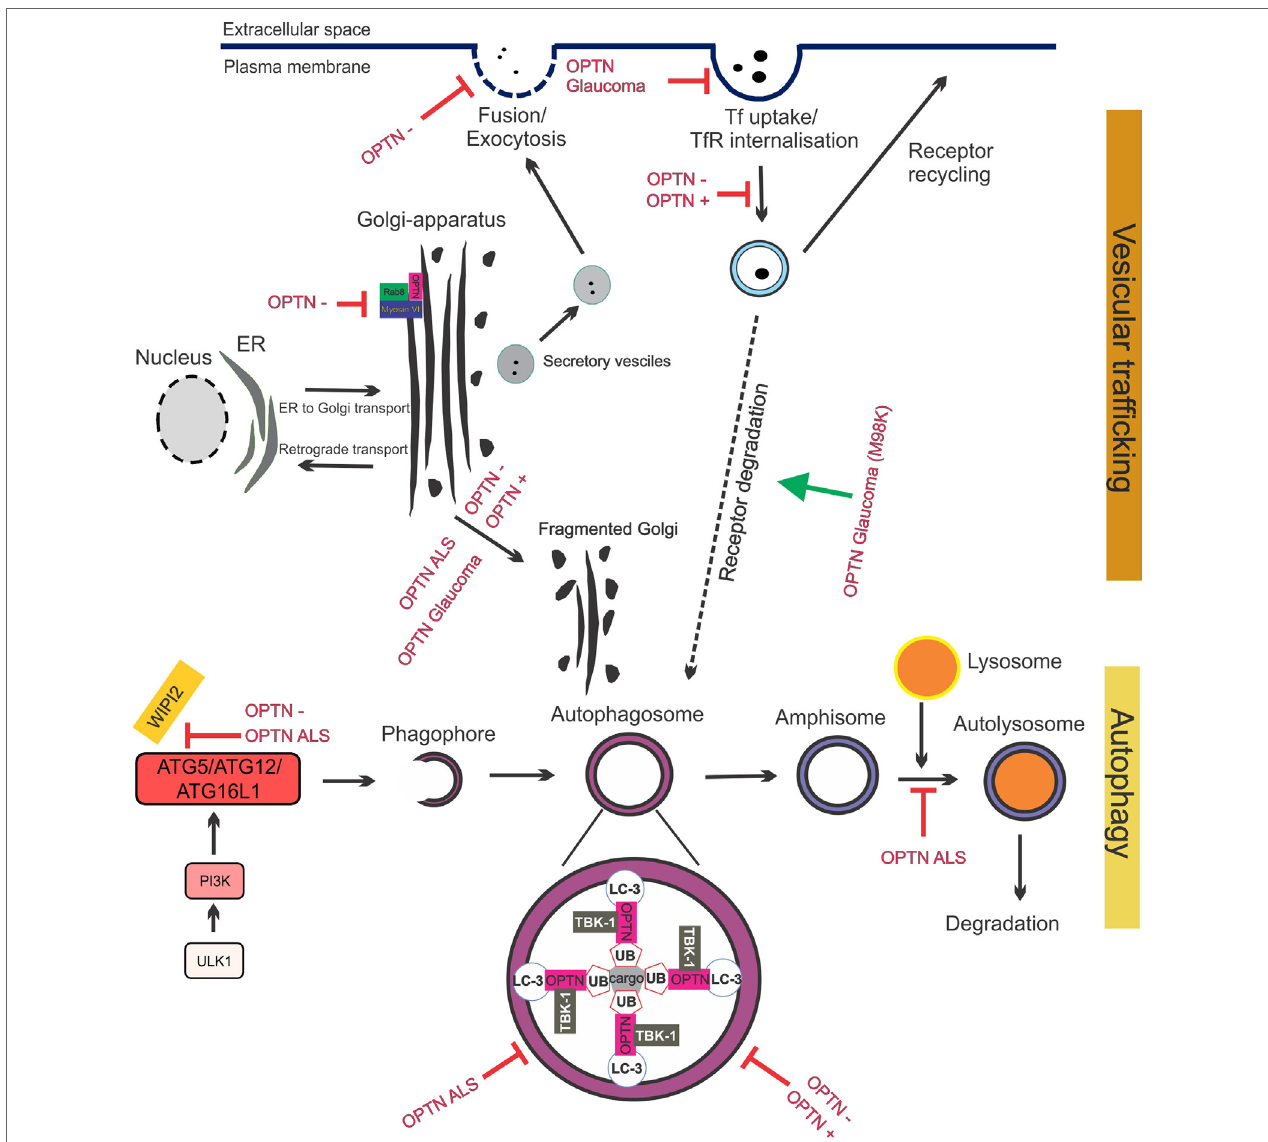
FiGURe 4 | Optineurin mediates vesicular trafficking, receptor recycling and autophagy. (1) Optineurin controls Rab8 and myosin localization at the Golgi apparatus. Depletion of optineurin relocates the optineurin–Rab8–myosinVI complex from the Golgi. (2) Depletion of optineurin or overexpression of wild-type, ALS, or glaucoma mutant optineurin, results in Golgi fragmentation. (3) During vesicular trafficking, secretory vesicles travel from the Golgi to the plasma membrane where they fuse and undergo exocytosis. Depletion of optineurin abolishes the fusion of vesicles with the plasma membrane. (4) Transferrin receptor is recycled to the surface after transferrin uptake. E50K glaucoma mutant optineurin inhibits transferrin uptake, whilst depletion and overexpression of optineurin abolishes the recycling of transferrin receptor. M98K glaucoma mutant induces autophagic degradation of transferrin receptors by targeting them to autophagosomes. (5) Optineurin disrupts autophagy at several stages. The formation of the phagophore and autophagosome is inhibited by depletion of optineurin, as well as overexpression of ALS mutant optineurin, by inhibiting ATG5/ATG12/ATG6L1 complex formation. Optineurin links the ubiquitinated cargo to LC3, together facilitating autophagosomal engulfment of the cargo. Degradation of cargo, such as mitochondria and protein aggregates, is inhibited by both ALS and glaucoma mutant optineurin. Imbalance of optineurin expression, such as its overexpression or depletion, also interferes with autophagy, decreasing the clearance of cargo. ALS-associated mutant optineurin further blocks the fusion of the autophagosome to the lysosome, further inhibiting autophagy flux. Abbreviations: OPTN − : optineurin depletion, OPTN + : optineurin overexpression, OPTN ALS: ALS mutant optineurin, OPTN glaucoma: glaucoma mutant optineurin, Tf: transferrin, TfR: transferrin receptor, ER: endoplasmic